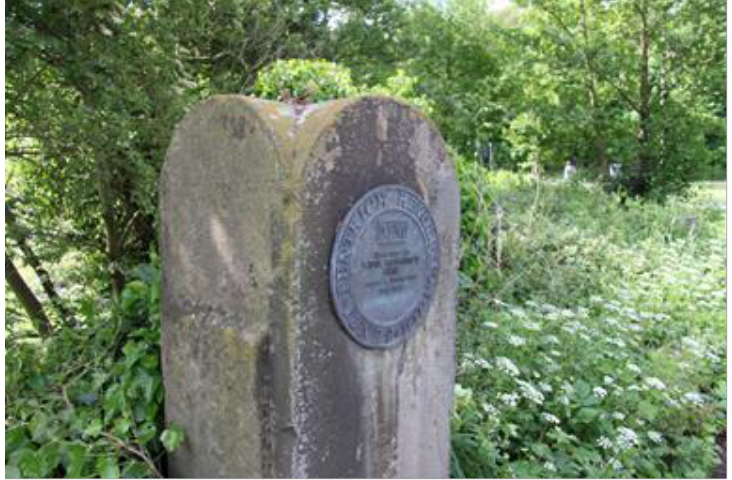
Figure 1. The plaque, which reads ‘Pentrich Revolution 9 June 1817. Near here was Widow Hepworth’s farm where a servant was shot dead’. 1